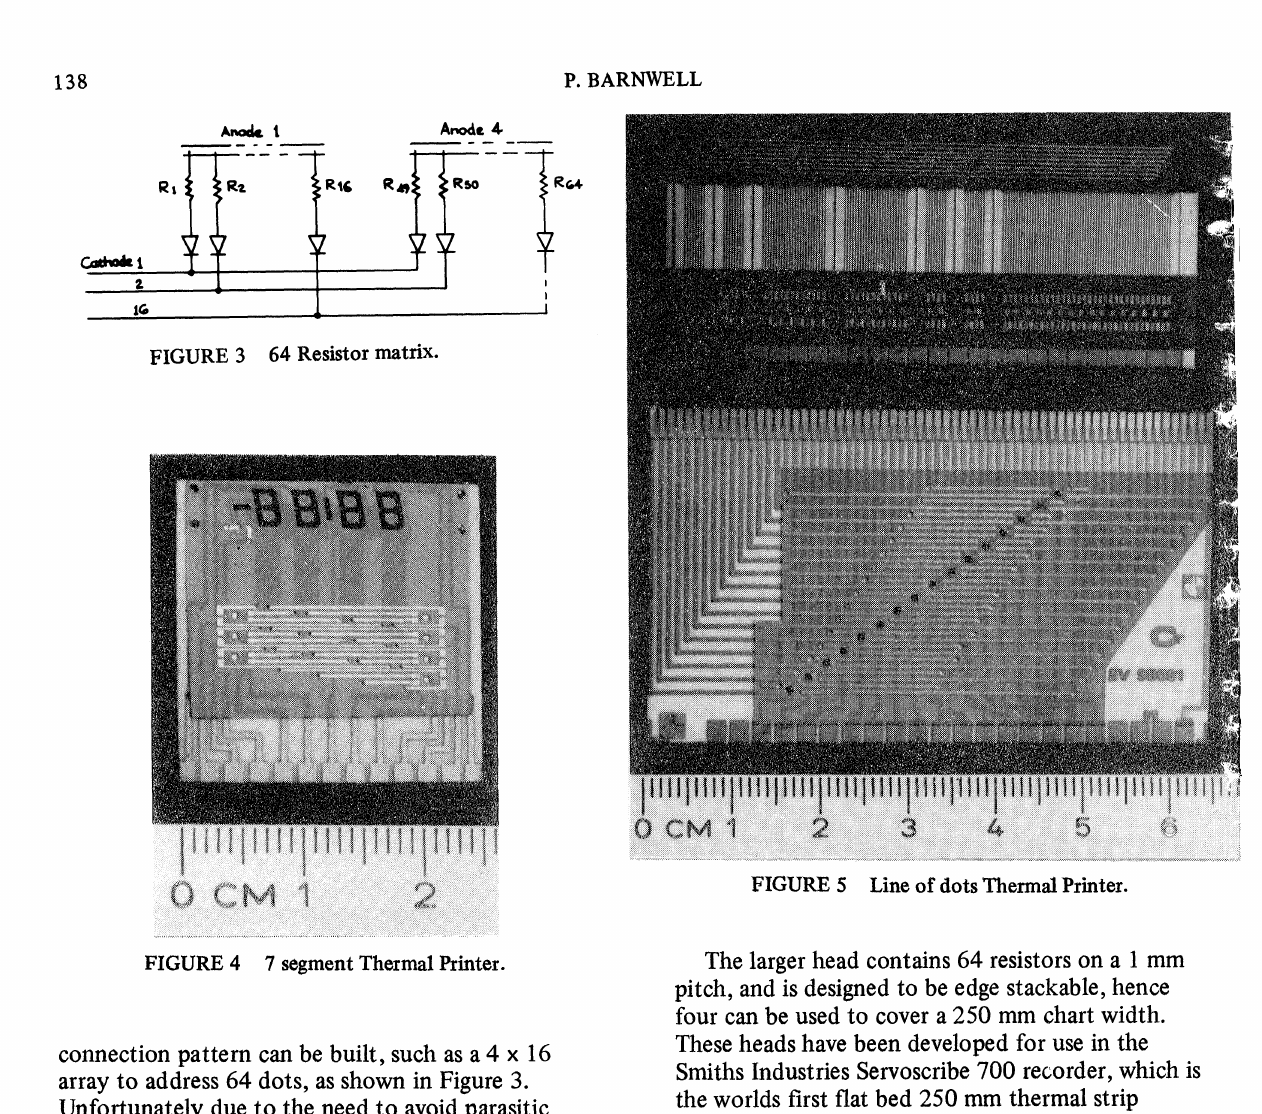
FIGURE 4 7 segment Thermal